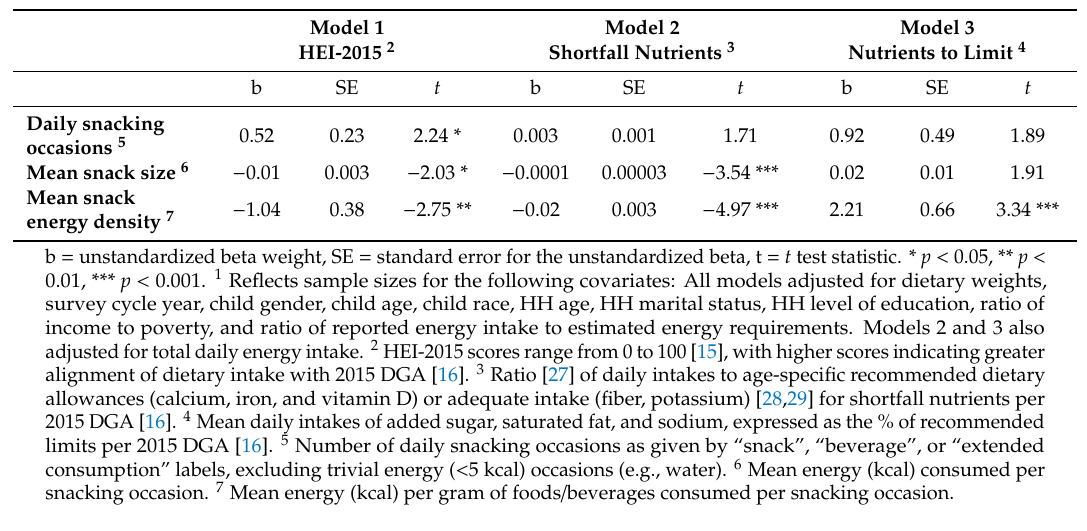
Table 3. Association between snacking parameters and diet quality among U.S. children aged two to five years ( n = 3679 1